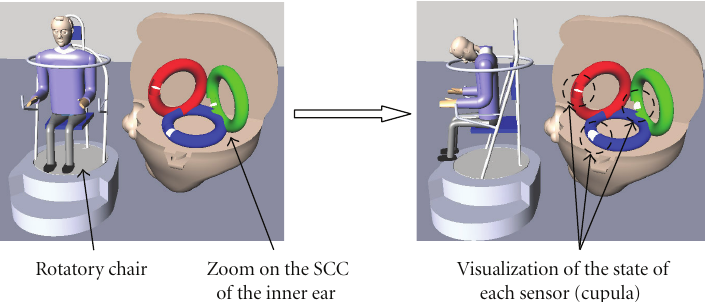
Figure 10: Visualization of a virtual scene: the state of each sensor can be visualized on real time during the test. The learning process is enhanced using user